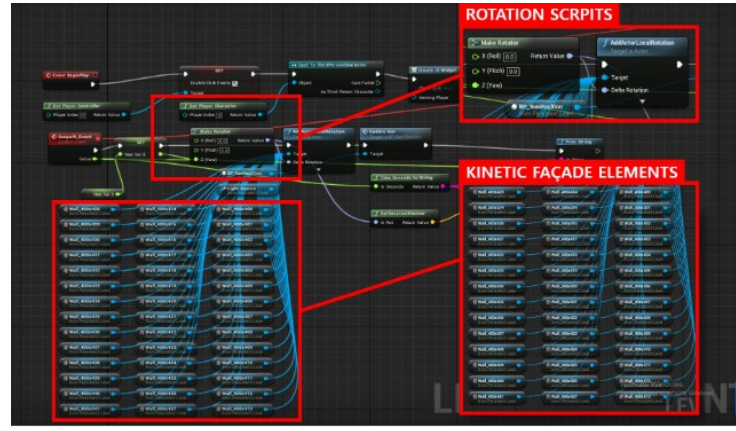
Figure 15. Virtual Reality Motion Animation Blueprint Visual Script System.